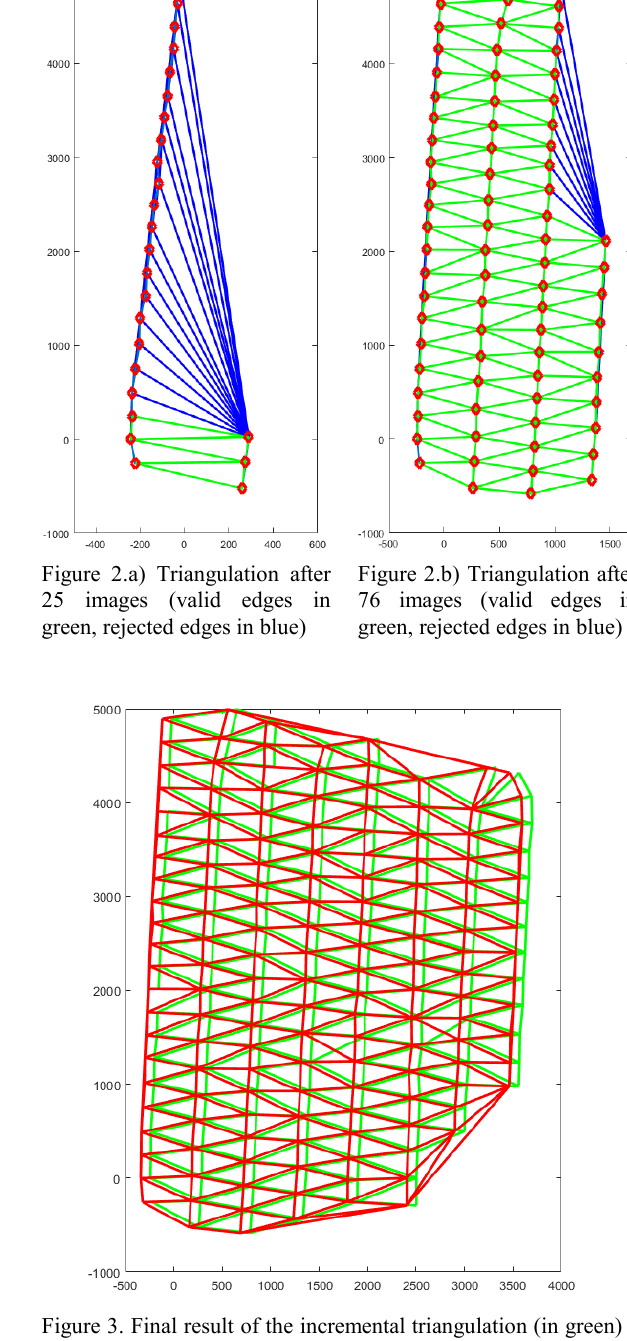
Figure 3. Final result of the incremental triangulation (in green) and the regular triangulation shifted (in red) 2.2 Feature Points Extraction and Matching For each recently captured image, the features points of this image are extracted using SIFT approach. The recently accepted edges of the last constrained triangulation after this image acquisition represents image pairs that have to be matched together. The image pair of each recently accepted triangulation edge is matched using the feature descriptors. This matching is refined to remove outlier matches using RANSAC algorithm (Fischler and Bolles, 1981). The RANSAC algorithm has been used to iteratively fit a fundamental matrix using the